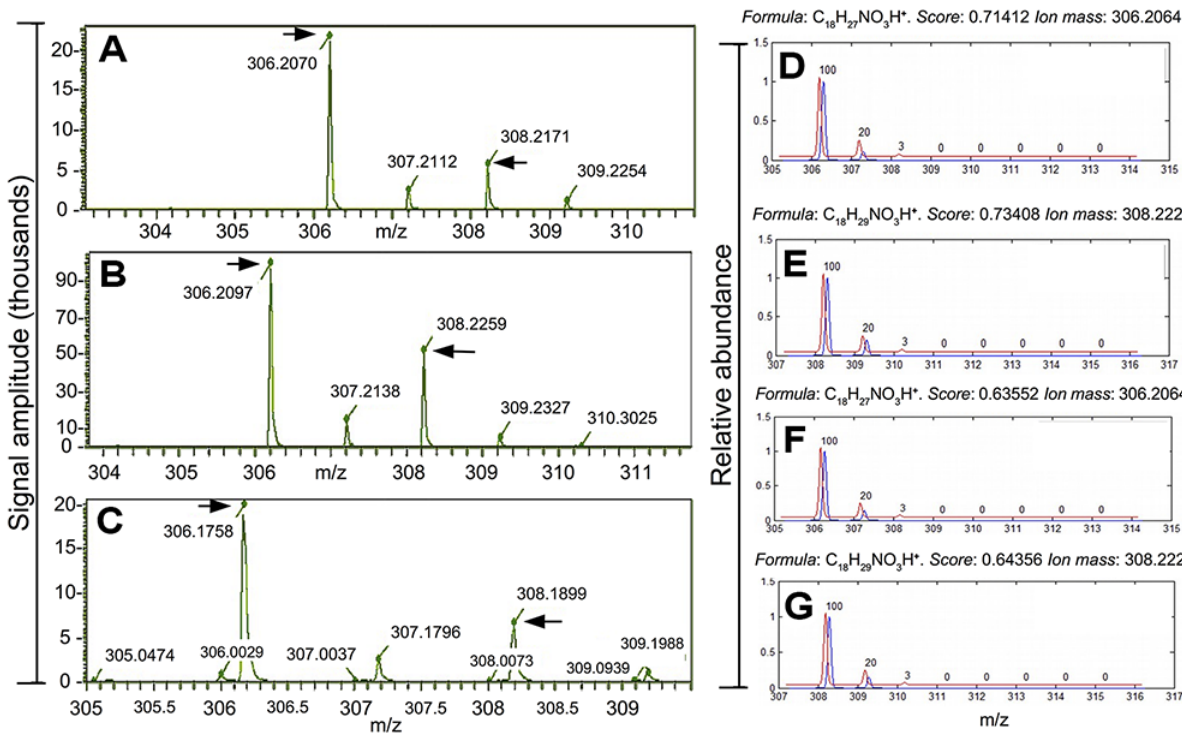
Fig. 6 Mass spectrometry peaks of capsaicin standard ( A ), C. annuum ‘Serrano’ extracts from green fruit ( B ), and from cell sus- pensions grown in MS-B5 liquid medium with 40 mM NaCl and in the dark ( C ). The signals corresponding to species of natural isotopic abundance were isolated using the Perkin–Elmer software and compared to the expected profile for capsaicin ( D,F ), or dihydrocapsaicin ( E,G ), for both the sample in ( A ), panes ( D,E ); and in ( C ), panes ( F,G ). The average (± SD ) mass error for capsaicin and dehydrocapsaicin, in ppm (= mg L −1 ), was 26.1 (±13.1) for the standard and extracts from fruit placenta, 203 (±70) for extracts from suspension cultures of WT cells, and 219 (±114) for extracts from suspension cultures of transformed cells, and the deviation from the expected isotopic mass distribution was from 5% to 20%. The arrows ( A–C ) mark the peaks of capsaicin (right arrow) and the dihydrocapsaicin (left arrow). For an explanation of m / z ratios and the meaning of mass error, see “Material and